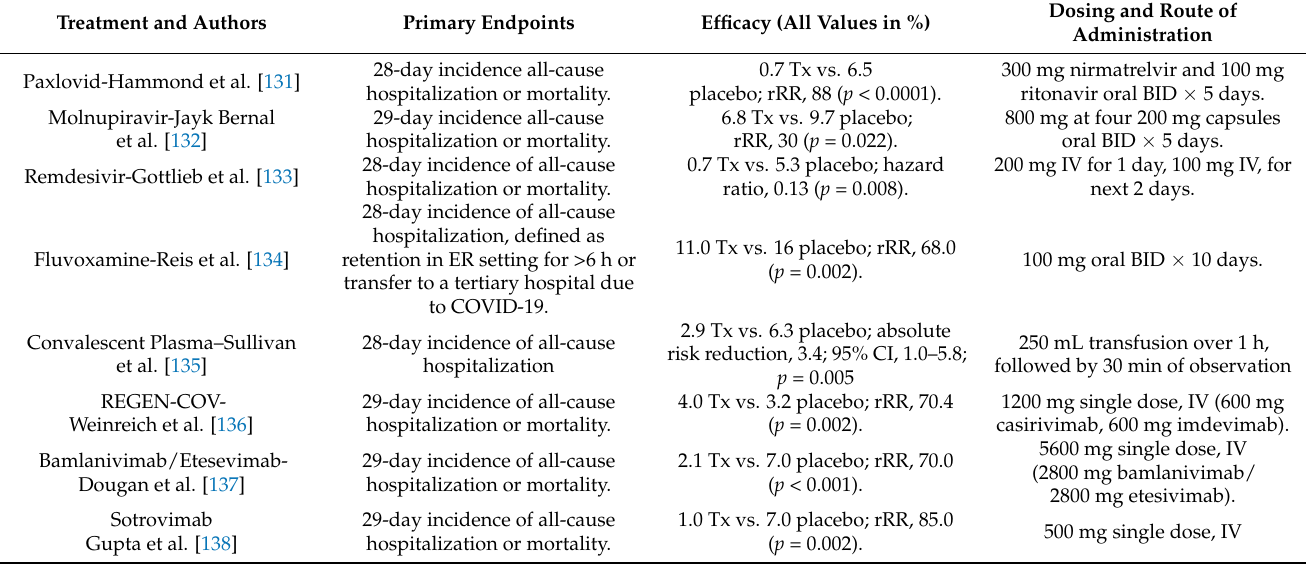
Table 4. Treatments with published clinical trials for mild-to-moderate COVID-19 non-hospitalized adults with high risk factors for